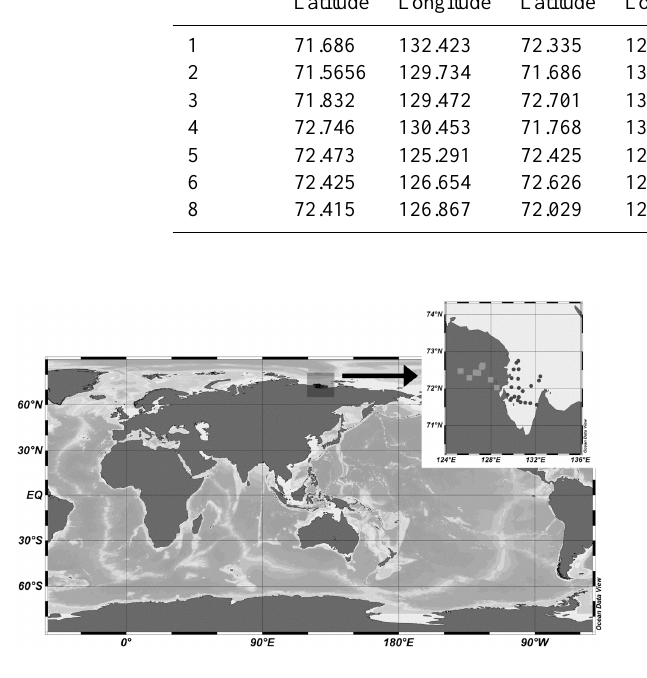
Fig. 1. Map of the Lena Delta and coastal Laptev Sea; the insert is showing the delta (light grey marks) and coastal (dark grey marks) stations sampled in 2010. Plots were generated using Ocean Data View software, v4.